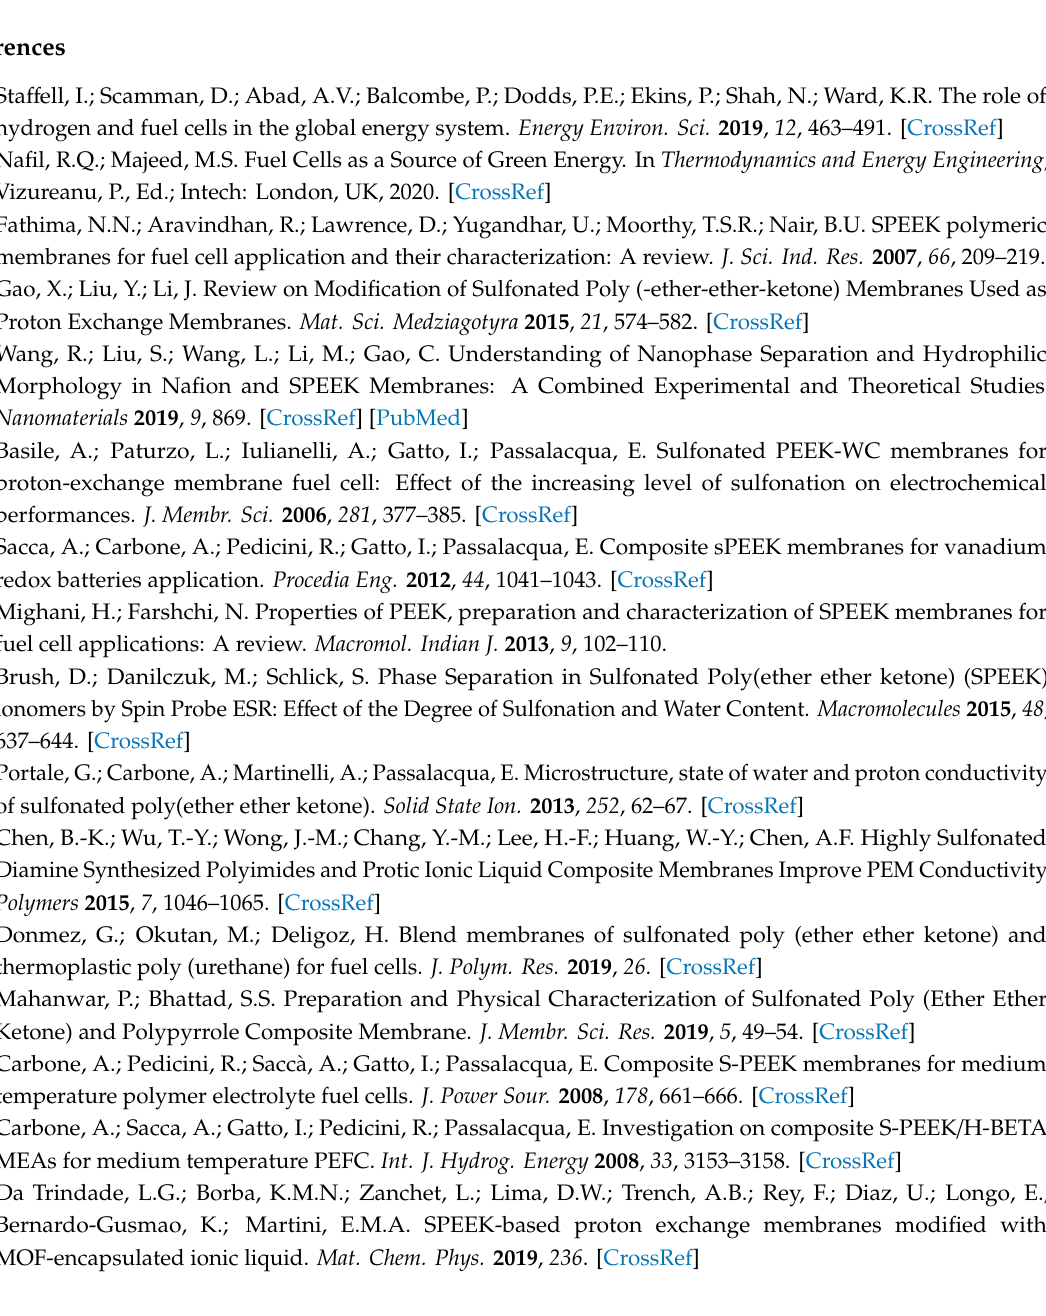
Figure S1: SEM Images of s-PEEK composite membranes, (a) s-PEEK; (b) s-PEEK-0.35; (c) s-PEEK-0.77; (d) s-PEEK-1.5; Figure S2: Extinction spectra of s-PEEK-0.77 composite membranes sulphonation degree 35% re-cast from DMAc (red line) and after dipping into alkaline NaOH, 1 M solution (black line) at 25 ◦